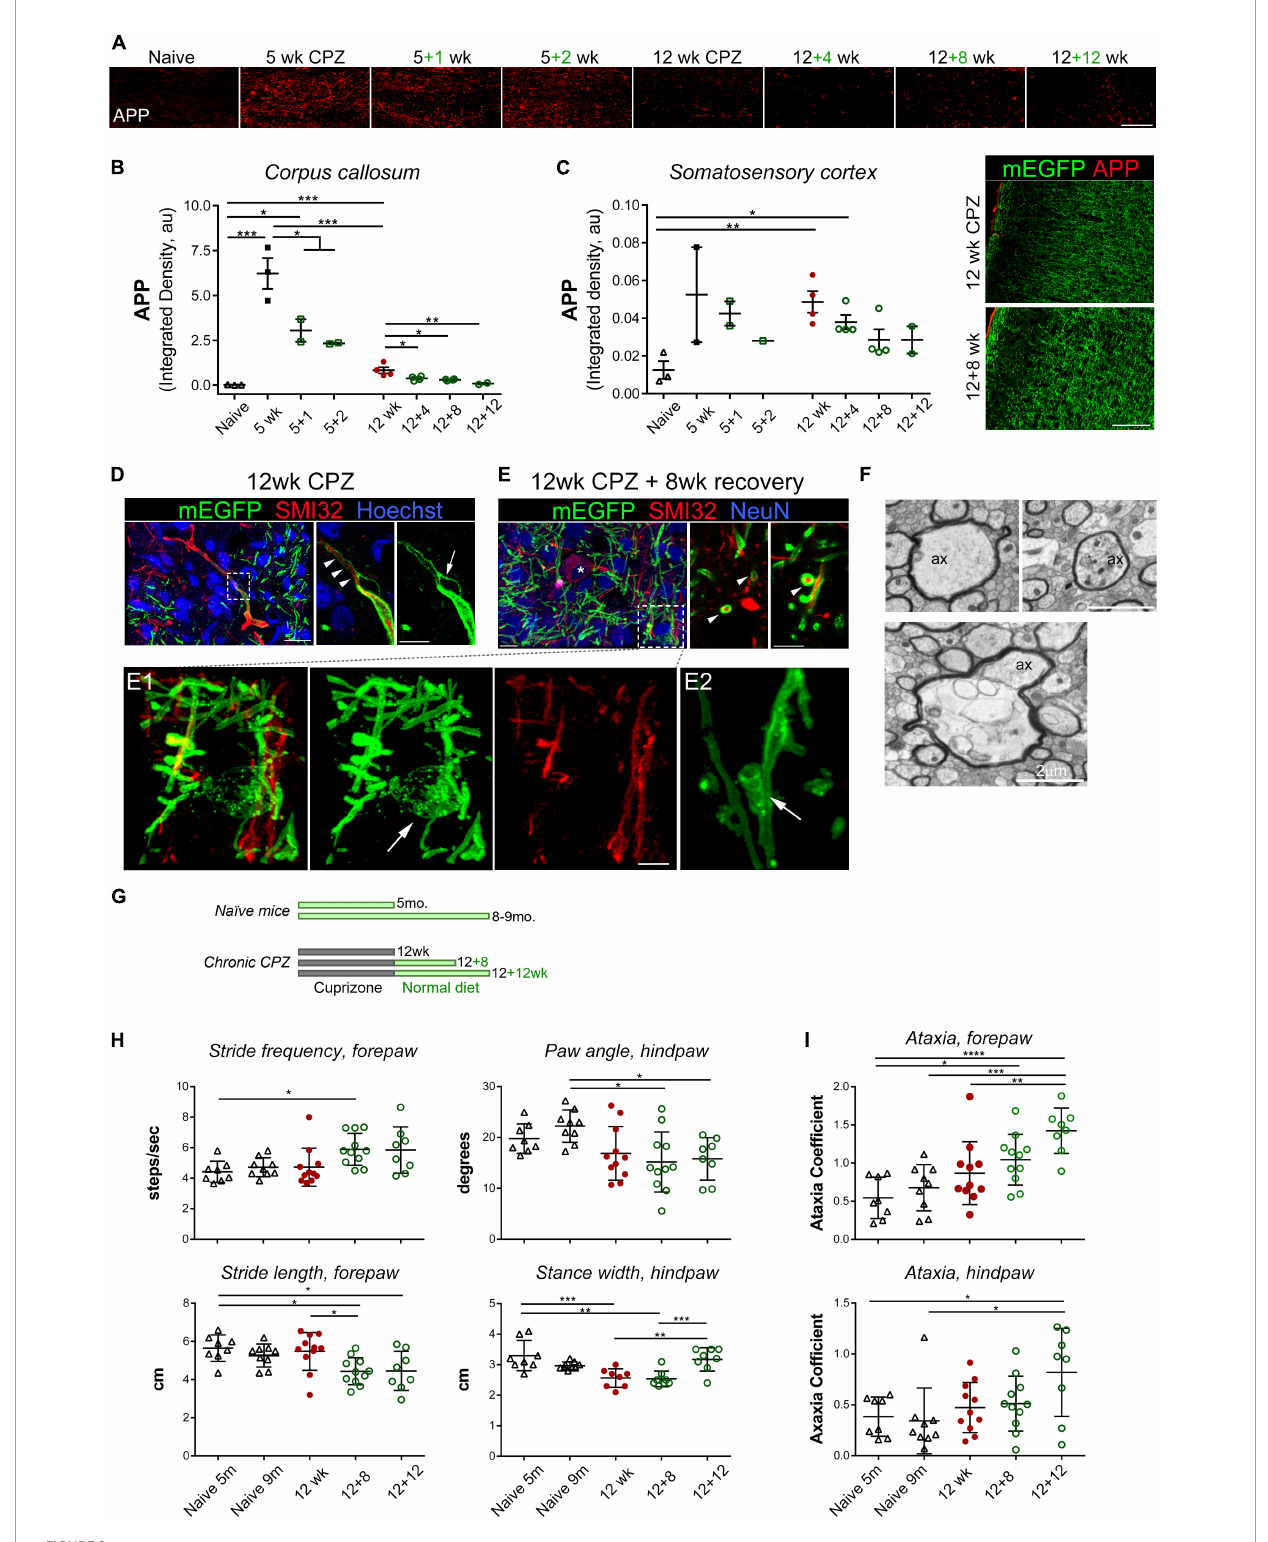
FIGURE2 Chronic demyelination is associated with axonal damage and the development of bilateral sensorimotor deficits during extended recovery. (A) Representative APP immunostaining images of the medial corpus callosum of control and mice treated with cuprizone for 5 and 12 weeks followed by 1–12 weeks of recovery. (B,C) Quantification of axonal damage based on integrated density of APP immunoreactive signal in the medial corpus callosum (B) and somatosensory cortex (C) . Data represent mean ± SEM of individual mice. * p < 0.05; ** p < 0.01; *** p < 0.001. One-way ANOVA with Tukey’s post-hoc correction. For 5 weeks versus 12 weeks, unpaired Student’s t -test. (D) Maximum projection of confocal images of immunostained cortex of CNP-mEGFP mice treated with cuprizone for 12 weeks, showing a representative SMI32 + axon with mEGFP + myelin sheaths (left, z-stack depth: 12 µ m). Single z-stack plane of the boxed area is zoomed-in on the right. Arrowheads indicate a SMI32 + axon remaining myelinated, and arrow denotes a bubble-like splitting of myelin sheaths of the SMI32 + axon. Scale bars, 20 µ m (left), 10 µ m (right). (E)